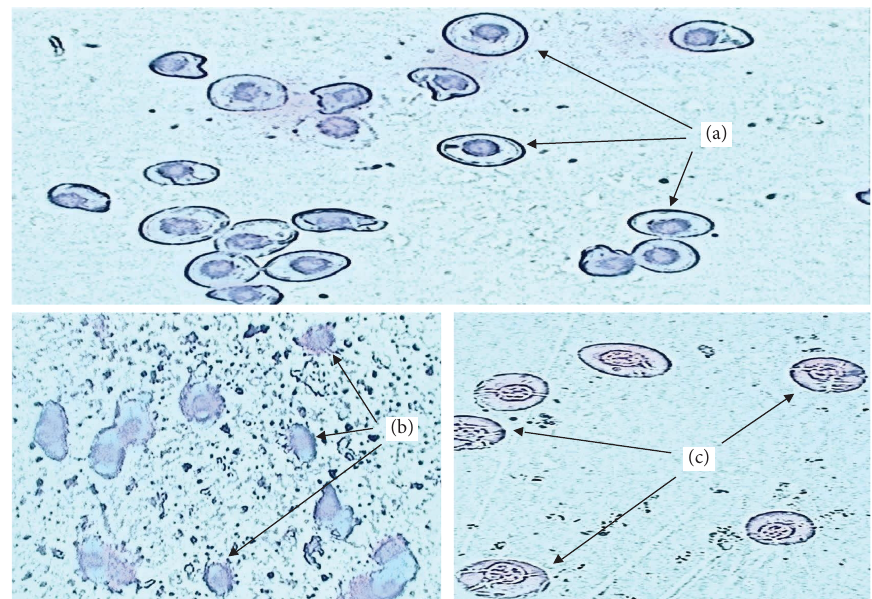
Figure 2: Tadpole frog ( Phrynobatrachus africanus Hallowell). (a) Mature erythrocytes; (b) erythroblasts; (c) degenerating erythrocytes.